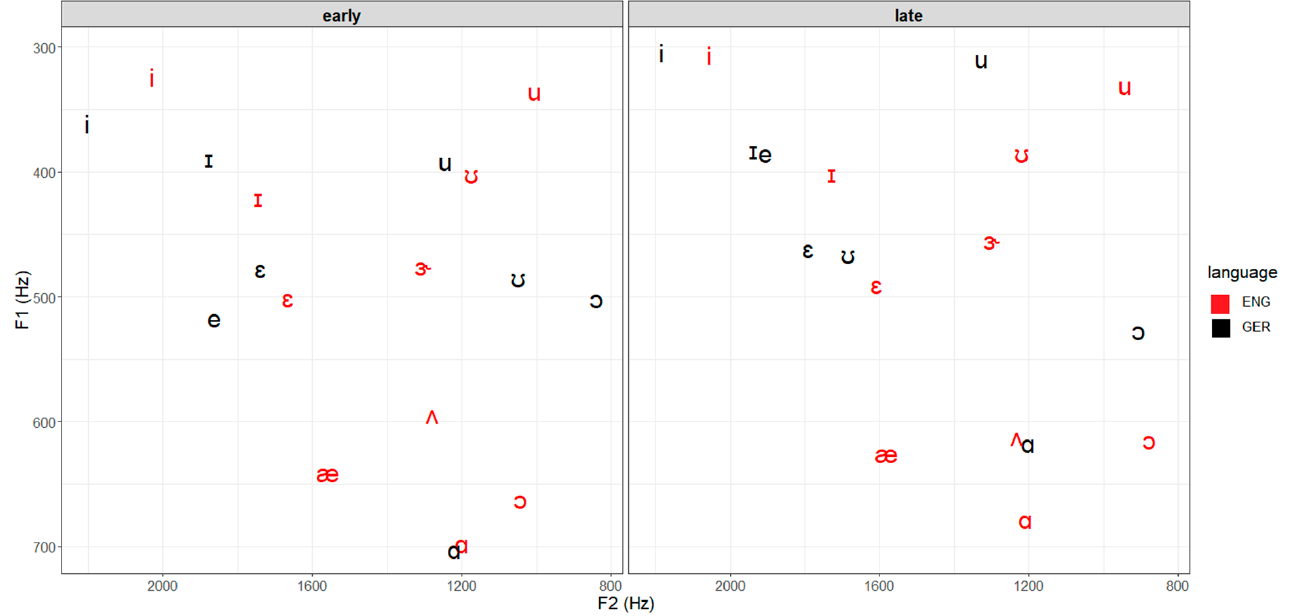
Figure 6. F1~F2 for AS’s German (GER) and English (ENG) vowels.